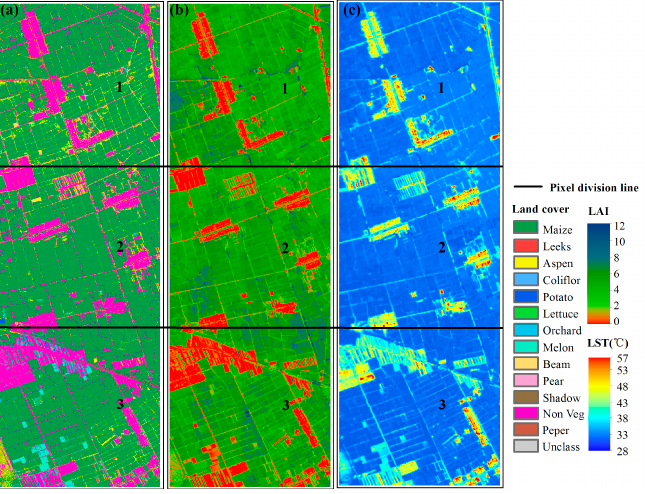
Figure 5. Data for each region on track 5-1: ( a ) 1-m classification data derived from CASI and ( b ) LAI and ( c ) LST retrieved by WiDAS.